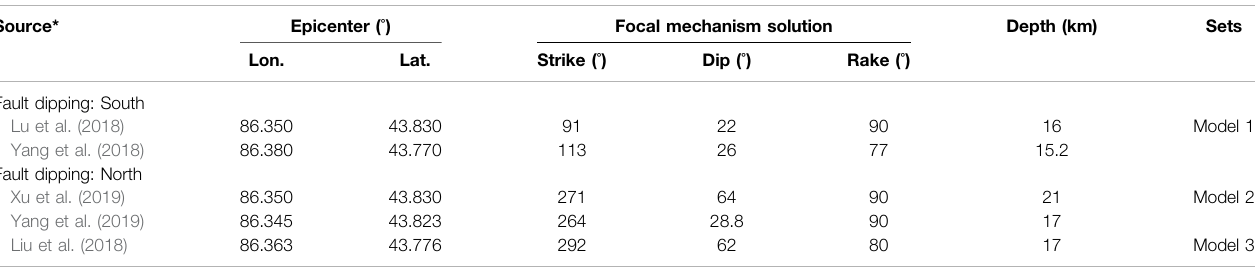
TABLE 3 | Compilation of the source parameters of the Mw 6.0 Hutubi earthquake from different data types Source*